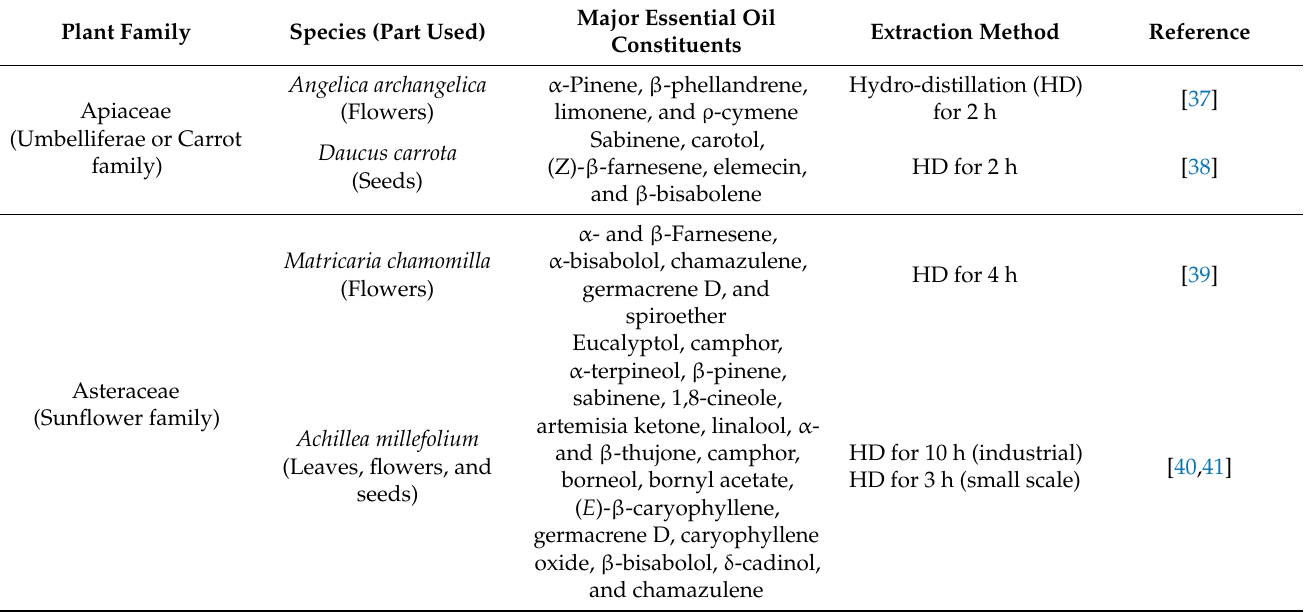
Table 1. Some Essential Oil-Bearing Plant Families with their Major Essential Oil